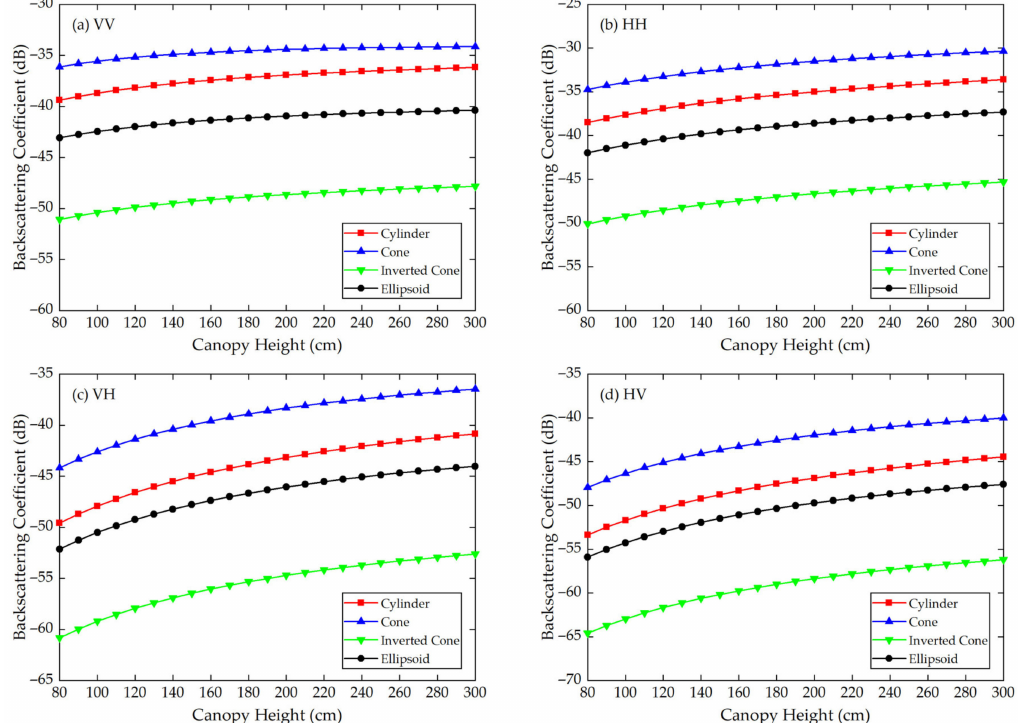
Figure 12. The MTVM simulation results of the backscattering coefficients for different crown shapes in X band (9.6 GHz)